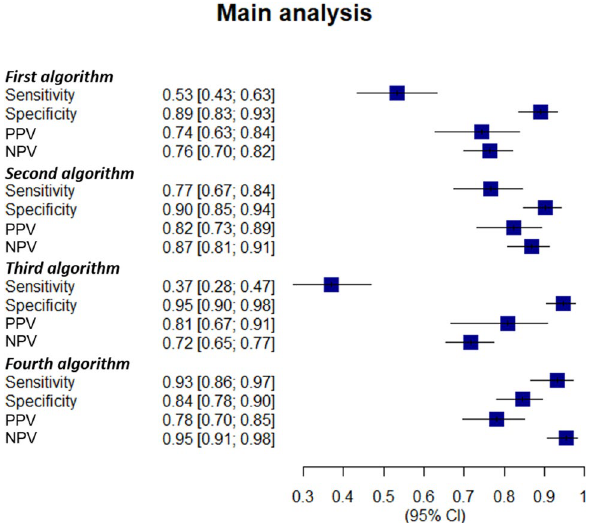
Figure 2. Validation of the algorithms used for selecting rheumatoid arthritis patients: the main analysis. The four algorithms were evaluated for: sensitivity (proportion of patients correctly classified as rheumatoid arthritis (RA) patients by the algorithm within the RA ones); specificity (proportion of patients correctly classified as without RA by the algorithm within patients without RA); positive predictive value (proportion of patients correctly classified as RA by the algorithm within all patients classified as RA by the algorithm) and negative predictive value (proportion of patients correctly classified as without RA by the algorithm within all patients classified as non-RA by the algorithm). Out of patients with the first bDMARD supply from 2014 to 2016 and at least one visit at the Rheumatology Unit of Pisa University Hospital from 2013 to the index